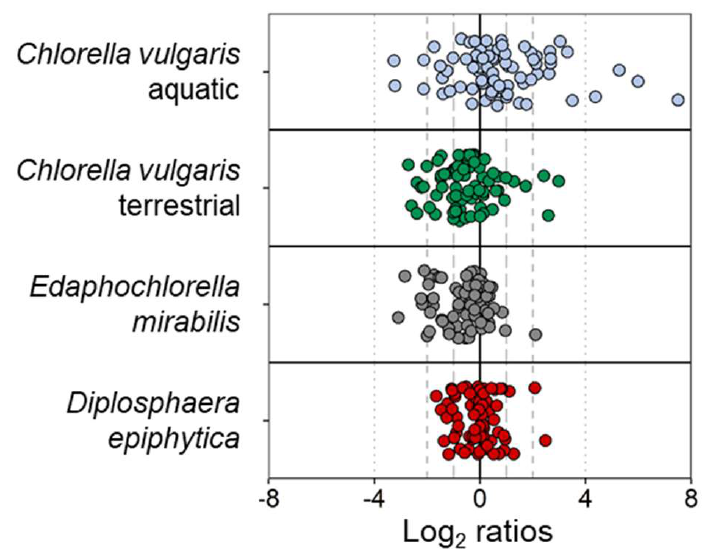
Figure 6. Changes in metabolite profiles before and after desiccation and rehydration in each of the four algal strains. Out of a total of 75 metabolites, 13, 22, 25, and 38 metabolites showed an absolute log 2 ratio above 1 in Diplosphaera epiphytica (red), Edaphochlorella mirabilis (grey), the terrestrial Chlorella vulgaris (green), and the aquatic Chlorella vulgaris strain (blue), respectively.